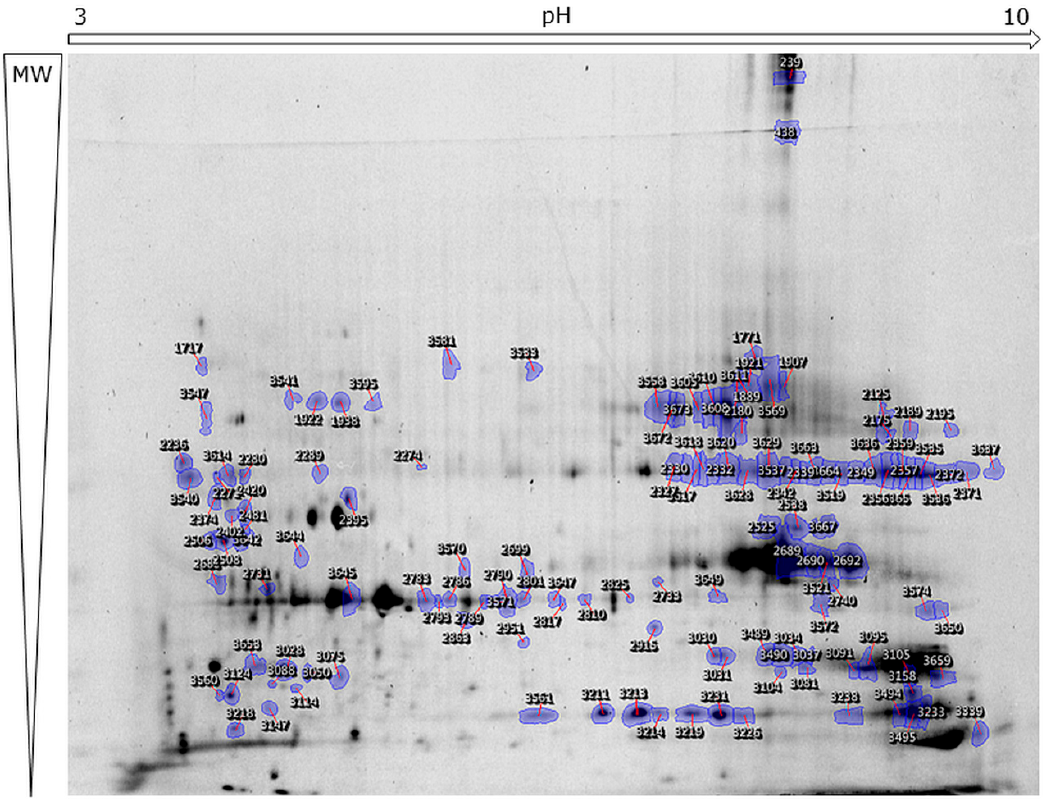
Figure 3. Illustration of 2D DIGE from the cell wall protein-enriched CaCl 2 fraction from leaves of M. sativa . Extractions were performed in four replicates. Proteins were pre-labelled with different CyDye to enable relative quantitative protein analysis. Labelled samples were loaded onto Immobiline TM DryStrip 3–10 NL, 24 cm (GE Healthcare) followed by migration on HPE TM Large Gel NF-12.5% (Serva Electrophoresis GmbH). Indicated spots were selected for picking based on statistical parameters calculated by the SameSpots software (TotalLab). Images of 2D DIGE from EGTA and LiCl fractions are provided in Figure S1. MW = molecular weight.